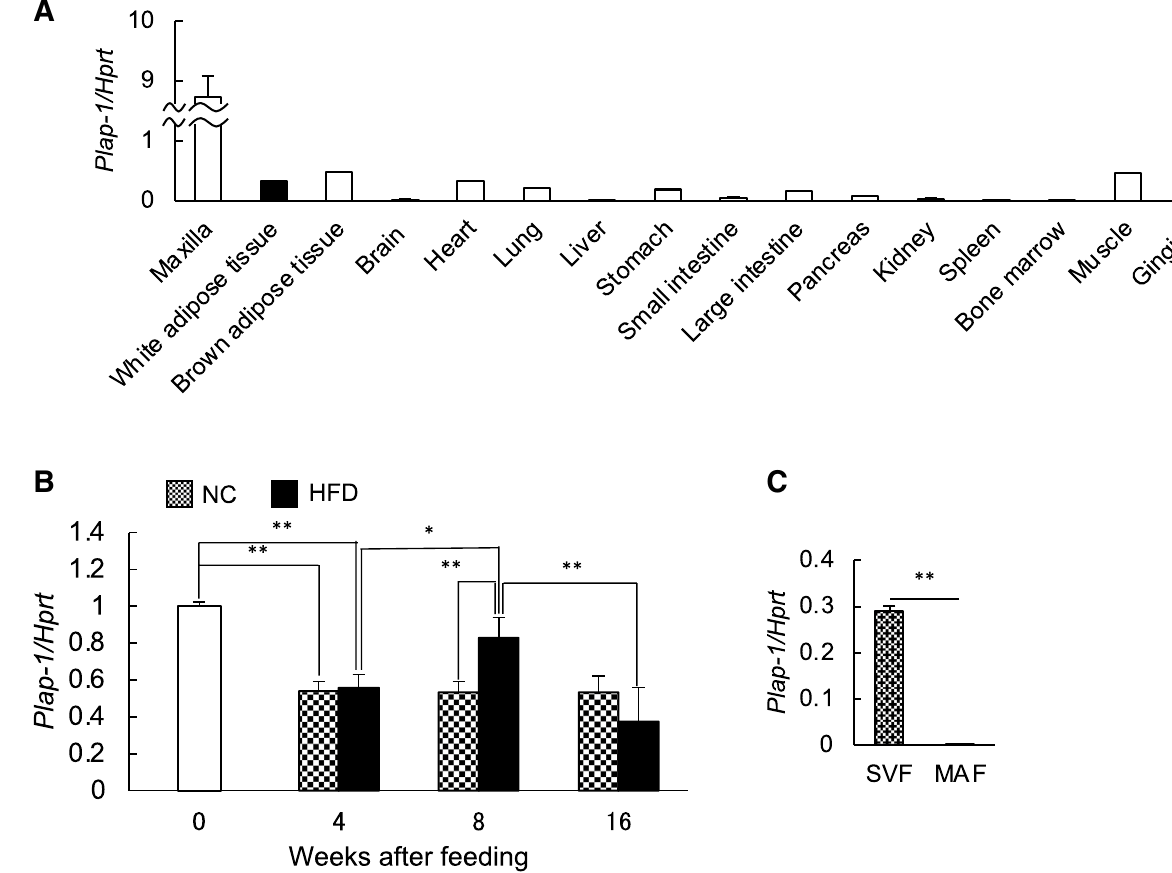
Figure 1. PLAP-1 is expressed in adipose tissue. ( A )Total RNA was extracted from various tissues and the expressions of Plap-1 were analyzed by real-time PCR analysis. Results show the mean ± SD of triplicate assays. ( B ) Plap-1 expression in epididymal adipose tissue was analyzed by real-time PCR analysis before or during NC or HFD feeding. 0: start point of NC or HFD feeding (five weeks of age) ( n = 3), 4: after 4 weeks NC or HFD feeding ( n = 5 in each group), 8: after 8 weeks NC or HFD feeding ( n = 5 in each group), 16: after 16 weeks NC or HFD feeding ( n = 5 in each group). ( C ) Real-time PCR analysis was performed to investigate Plap-1 expression in SVF and MAF isolated from WT and Plap-1 KO mice. Values represent the mean ± SD triplicate